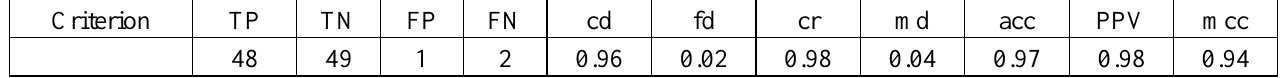
Table 2. Smoke detection performance comparison of proposed and two previously reported methods.